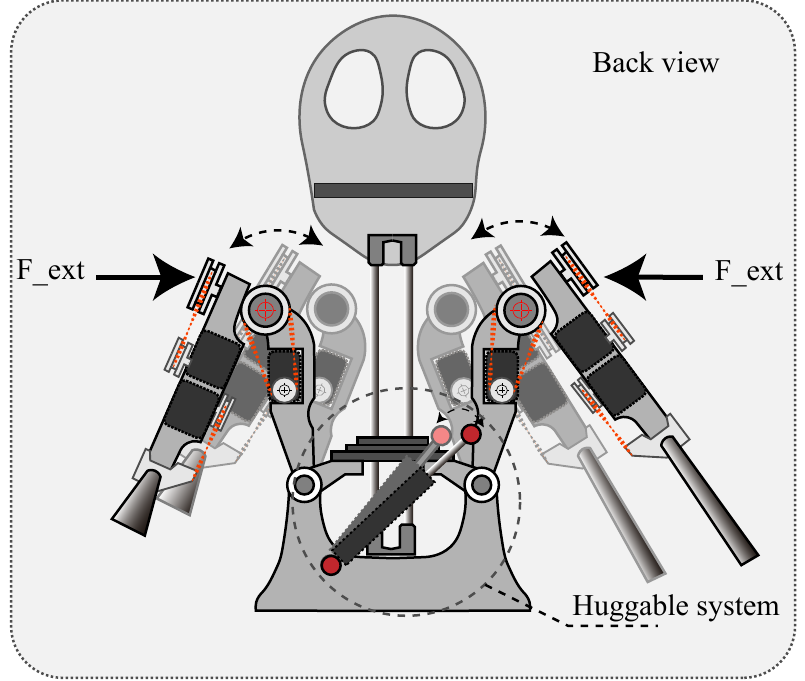
Figure 8. Mechanical design of the huggable structure. F_ext denotes external forces applied to the robot. The shaded drawing in the middle represents the movement performed by the system. The lower circle illustrates the pneumatic pistons for the huggable